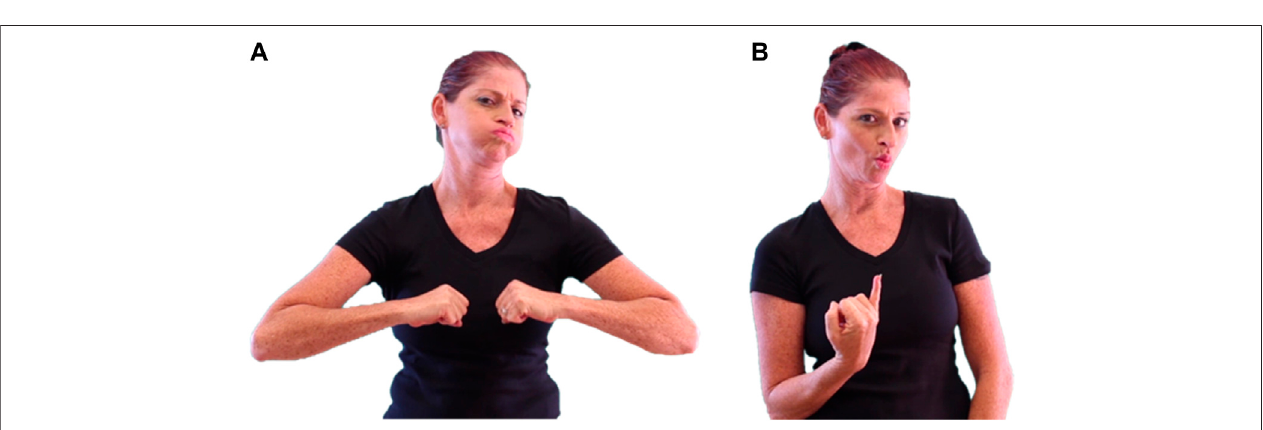
FIGURE 15 | ISL signs with iconic lexical (linguistic) mouth features. (A) FAT, (B) THIN.